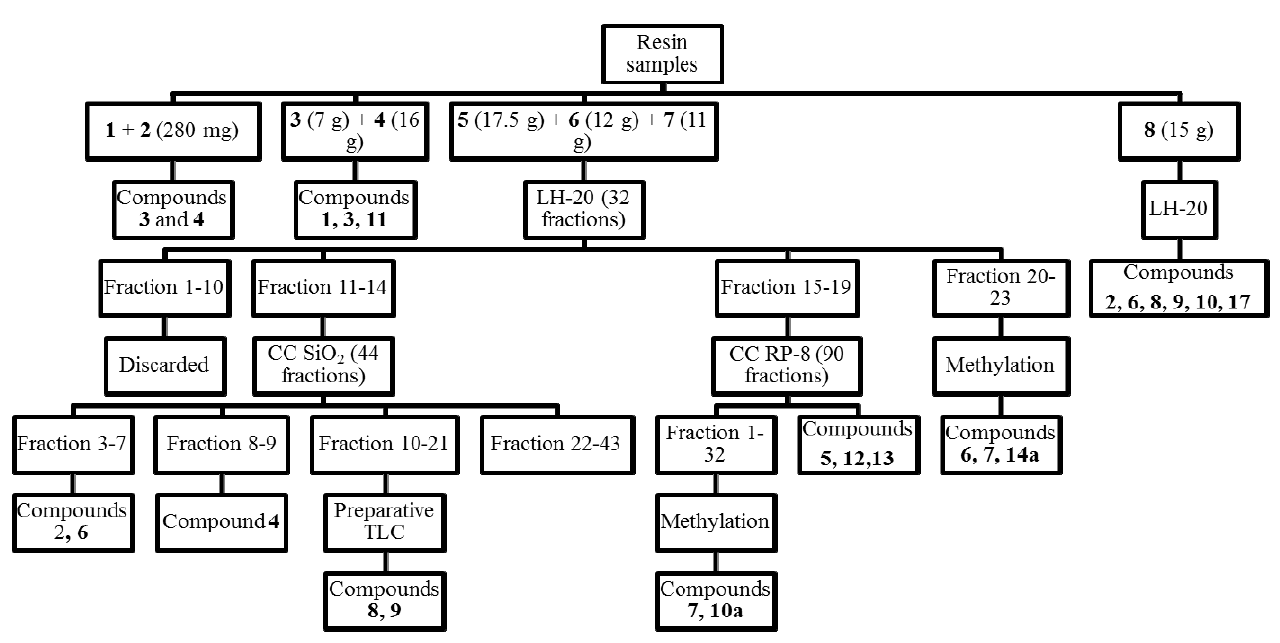
Figure 3. Flow chart summarizing the isolation of constituents from Austrocedrus chilensis